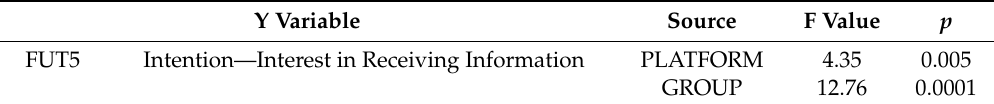
Table 9. Model with FUT5 “Intention/interest in receiving information”.